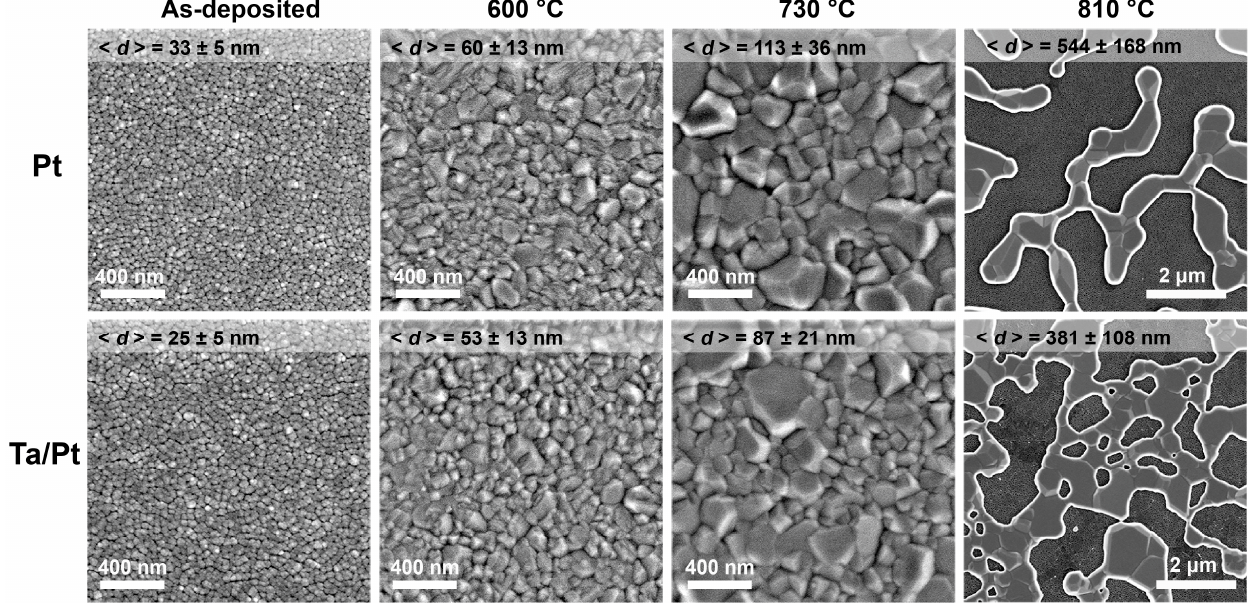
Figure 2. Scanning electron microscopy images of the surface of thin-film microheaters after annealing at different temperatures for 12 h at a heating rate of 2 °C/min. The average grain size is indicated at the top of each image.